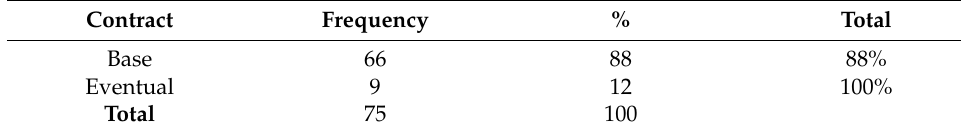
Table 5. Cumulative frequency of the contract type.